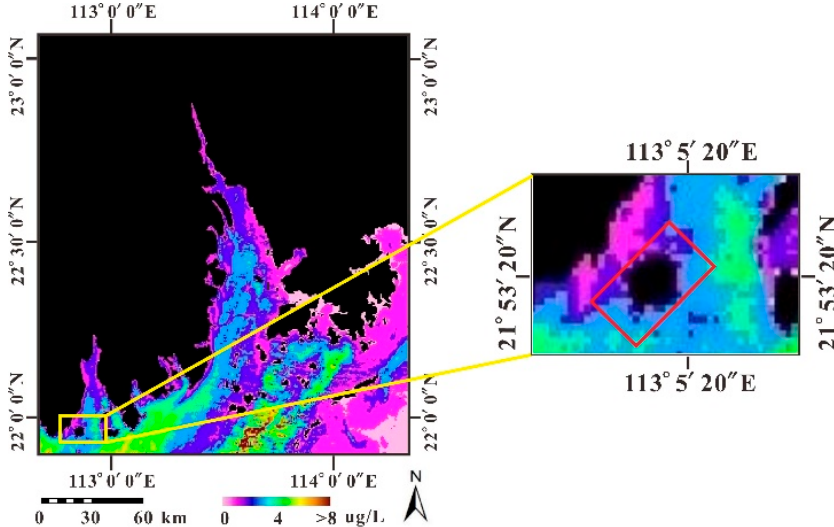
Figure 5. Distribution of Chl-a inversed by MODIS data in the Pearl River Estuary.